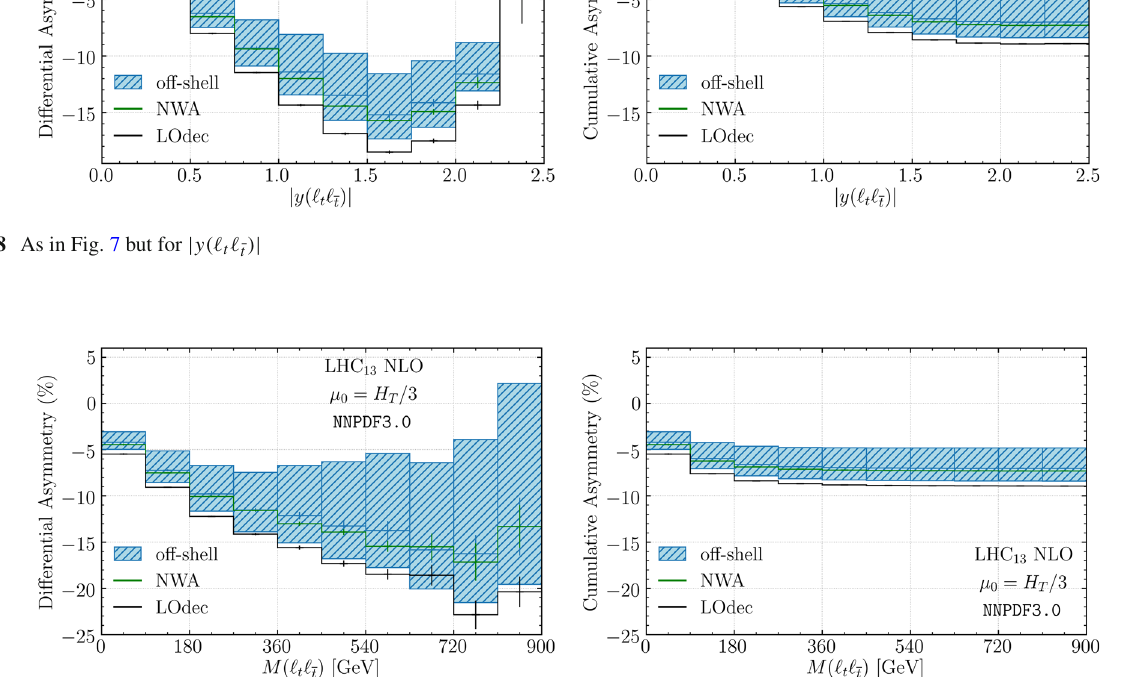
Fig. 9 As in Fig. 7 but for M ((cid:4) t (cid:4) ¯ t